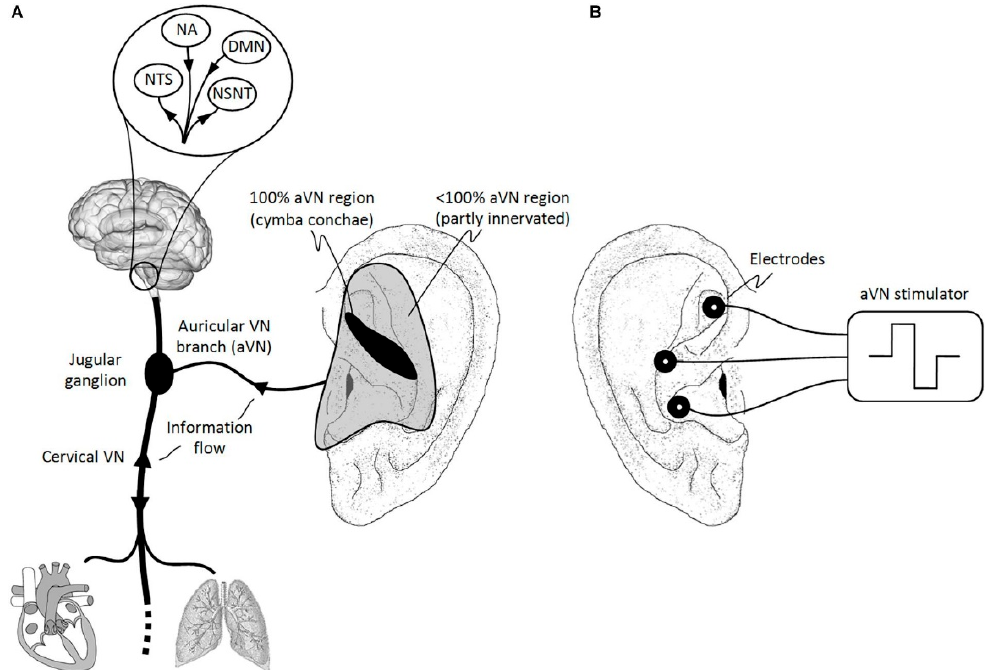
Figure 1. Natural sensory innervation of the auricle versus its artificial stimulation. ( A ) The vagus nerve (VN) connects the brain with most of the organs within the thorax and abdomen. Afferent auricular branches (aVN) leave the cervical VN at the level of the jugular ganglion just outside the cranium and innervate the rather central regions of the pinna of the outer ear (Peuker and Filler, 2002). ( B ) Electric stimulation of aVN endings with needle electrodes located within these central regions. NTS, nucleus of the solitary tract; NSNT, nucleus spinalis of the trigeminal nerve; NA, nu- cleus ambiguous; DMN, dorsal motor nucleus. This figure and figure caption were originally pub- lished in [6], which was published in Frontiers of Neuroscience under the creative commons attrib- ution license CC BY 4.0.